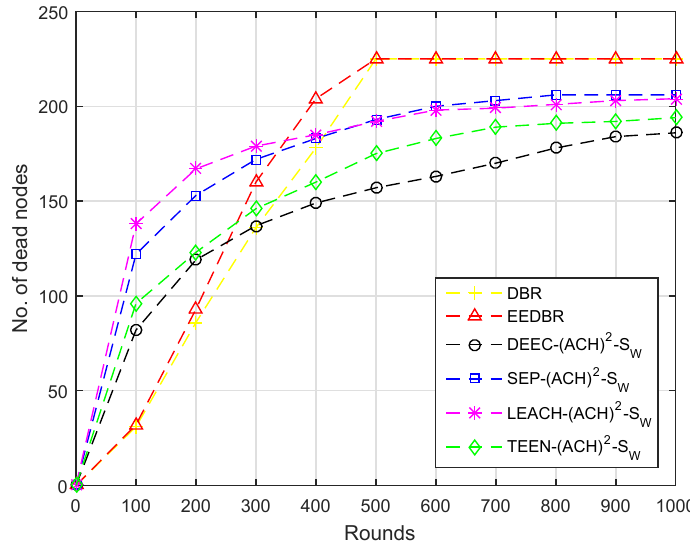
Figure 4. Number of Dead Nodes.